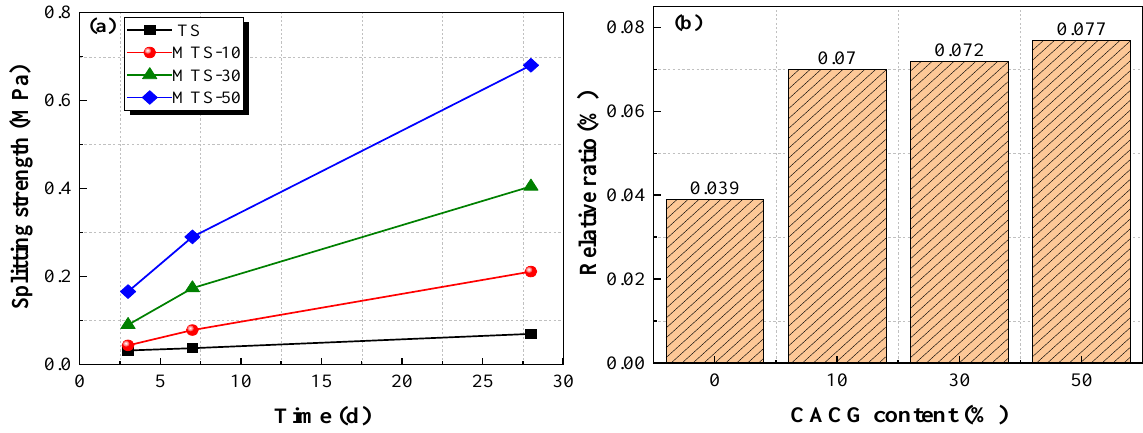
strength to unconfined compressive strength after curing for 28 days are shown in Figure 12.